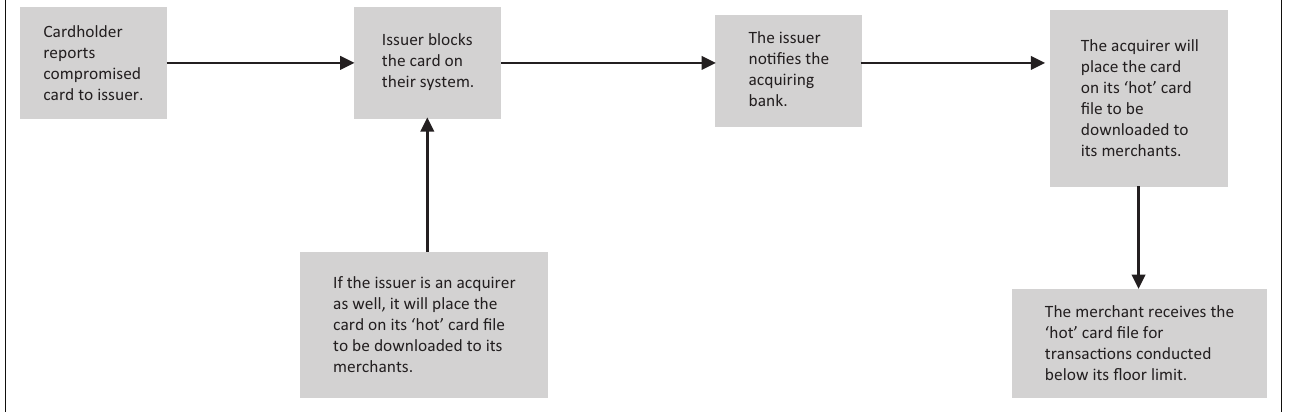
FIGURE 2: ‘Hot’ card file